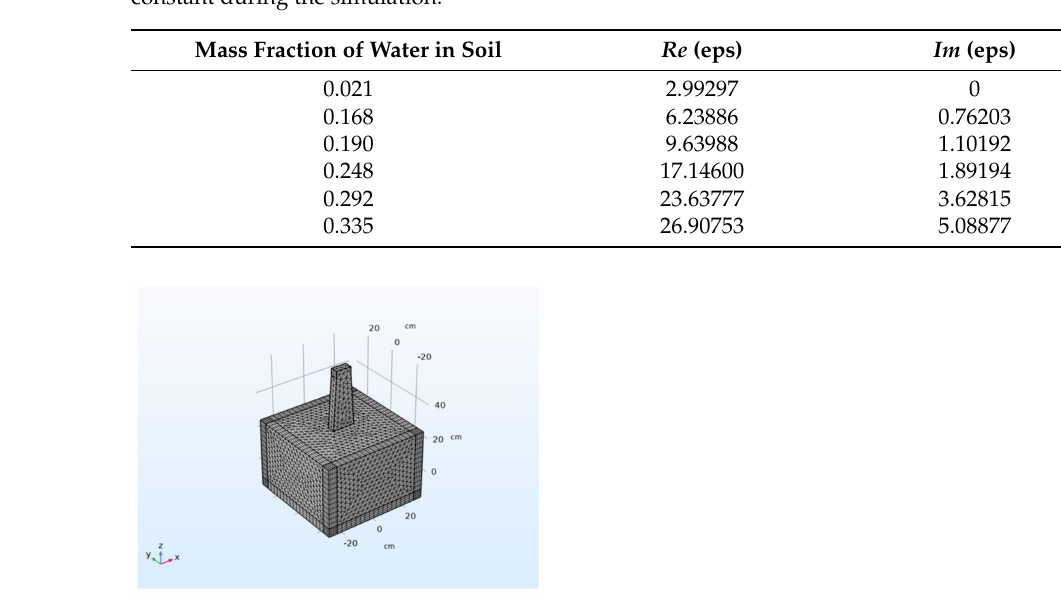
Figure 2. Meshing of the